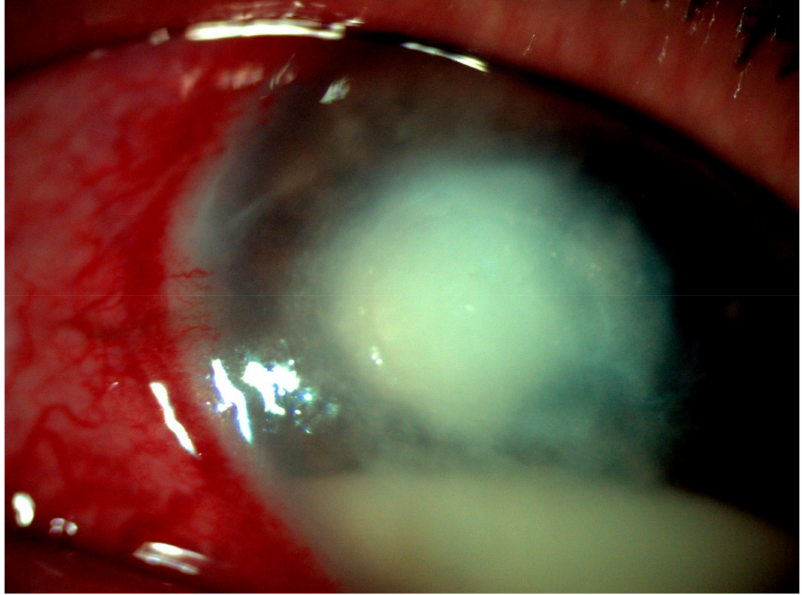
Figure 1. Greyish-white corneal infiltrate with feathery edges (5.5 mm × 6 mm) and multiple pin-head-sized peripheral satellite lesions with few tentacular